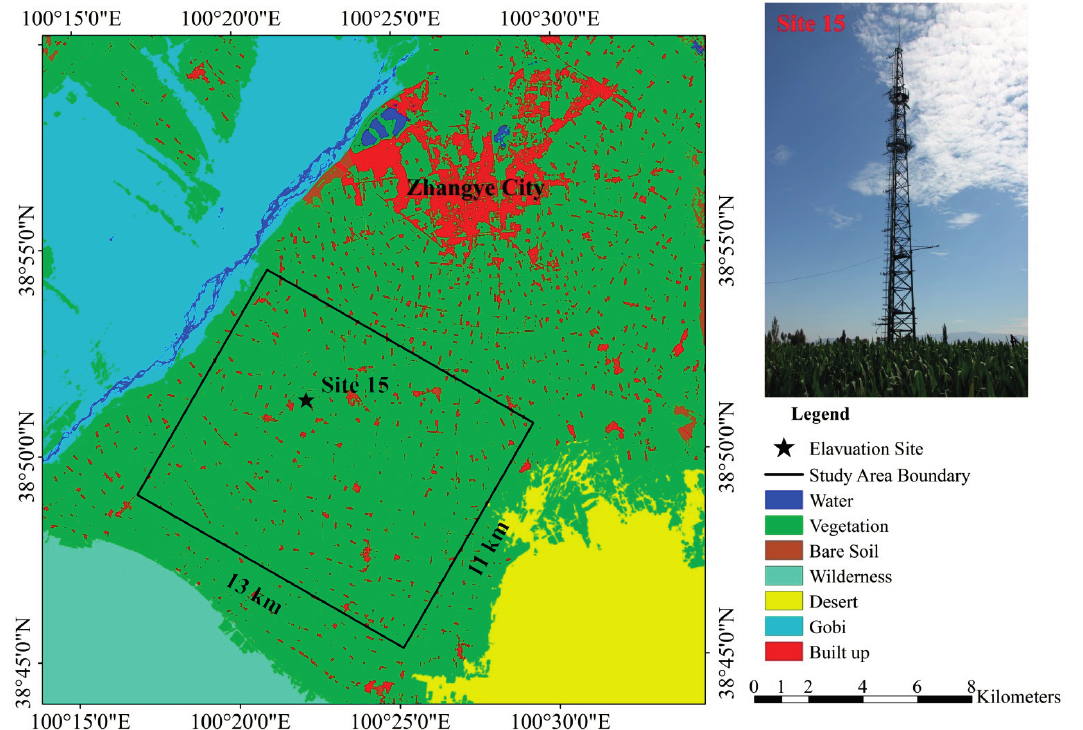
Figure 1. Spatial distribution and ground photographs of the six vegetation surface sites in this study. The upper left image is the landscape of the experimental HiWATER-MUSOEXE area, and the study area is the black rectangle with a length of 13 km and a width of 11